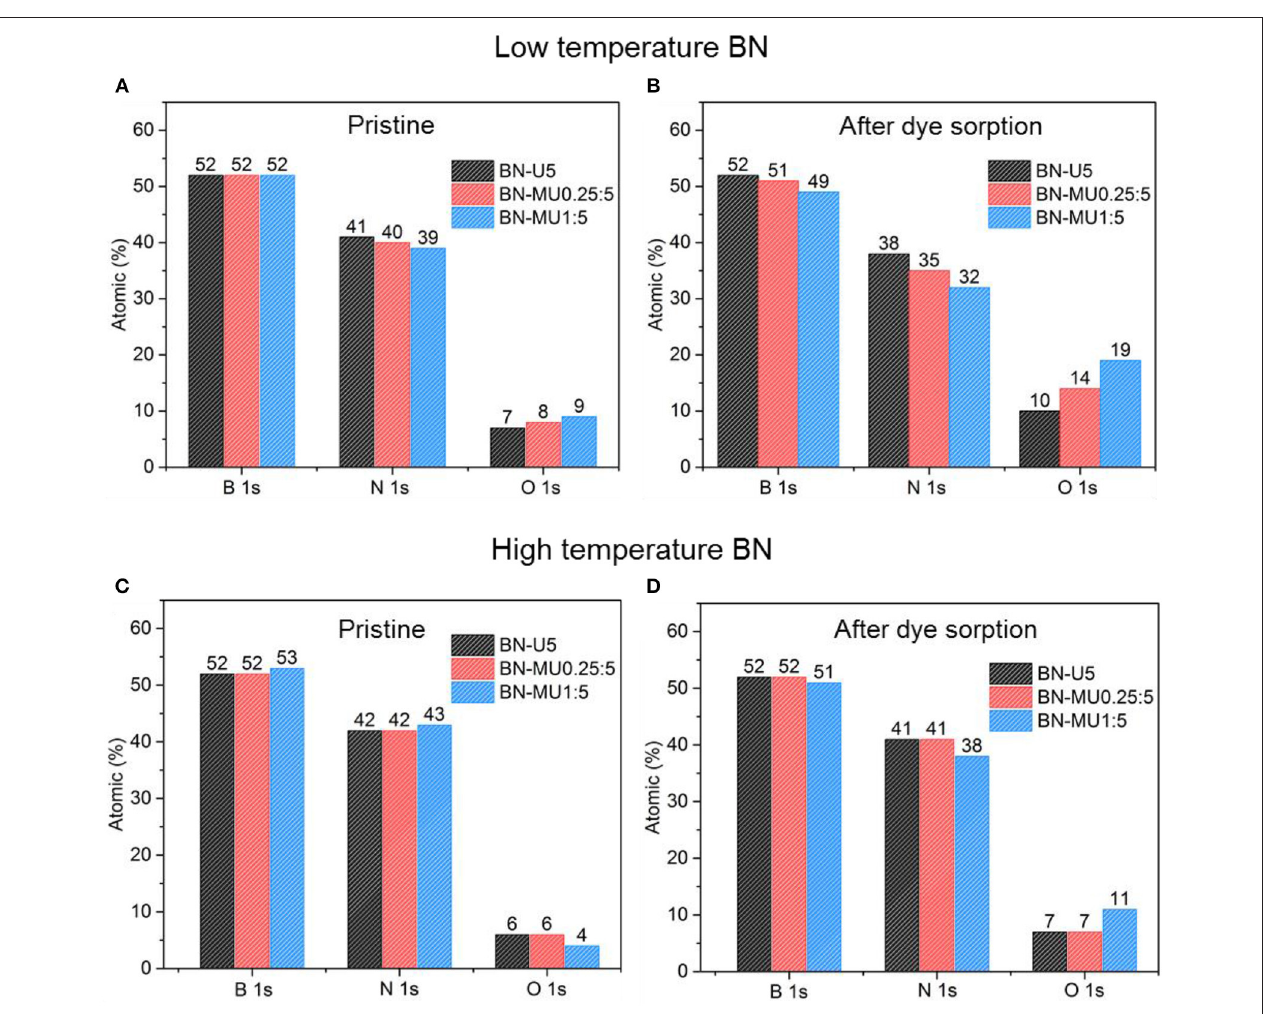
FIGURE 4 | Changes in the chemistry of the BN samples upon adsorption and regeneration at 600 ◦ C in air: (A,B) low temperature porous BN samples and (C,D) high temperature porous BN samples.